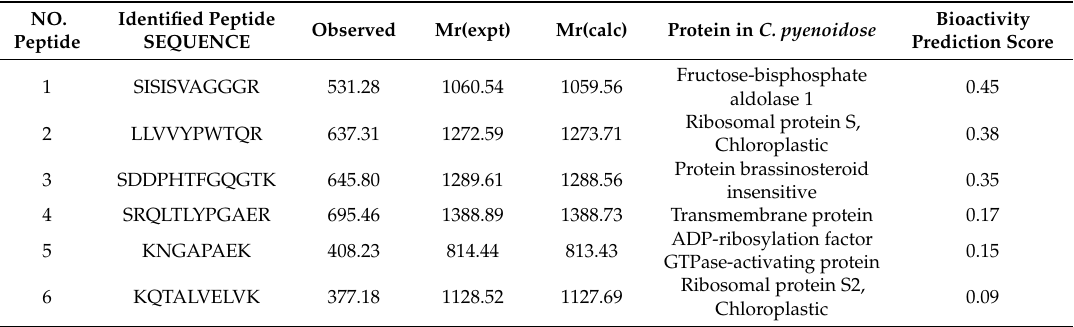
Table 3. Results of the identified peptides by Mascot Science and their bioactivity prediction by Peptide